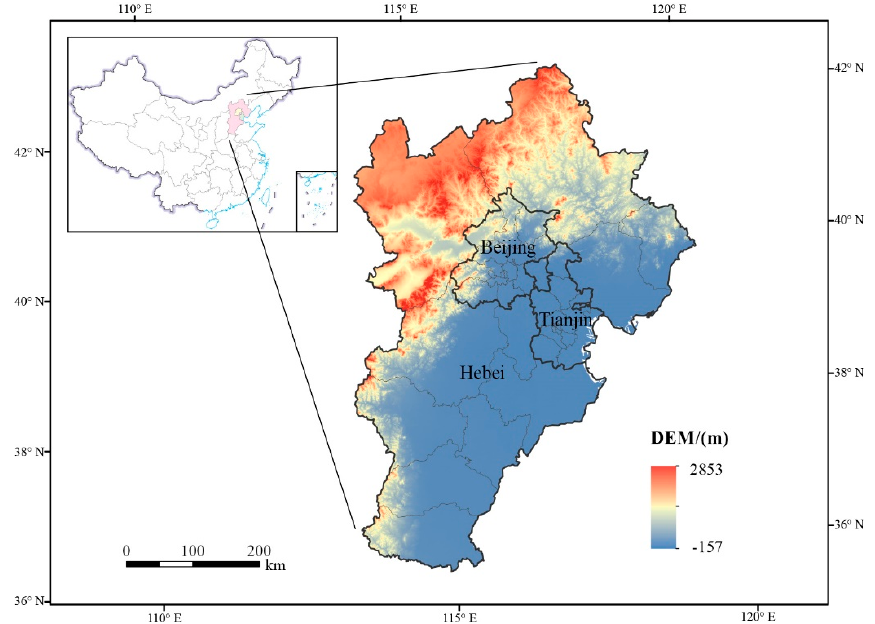
Figure 1. Geographical location of the study area .